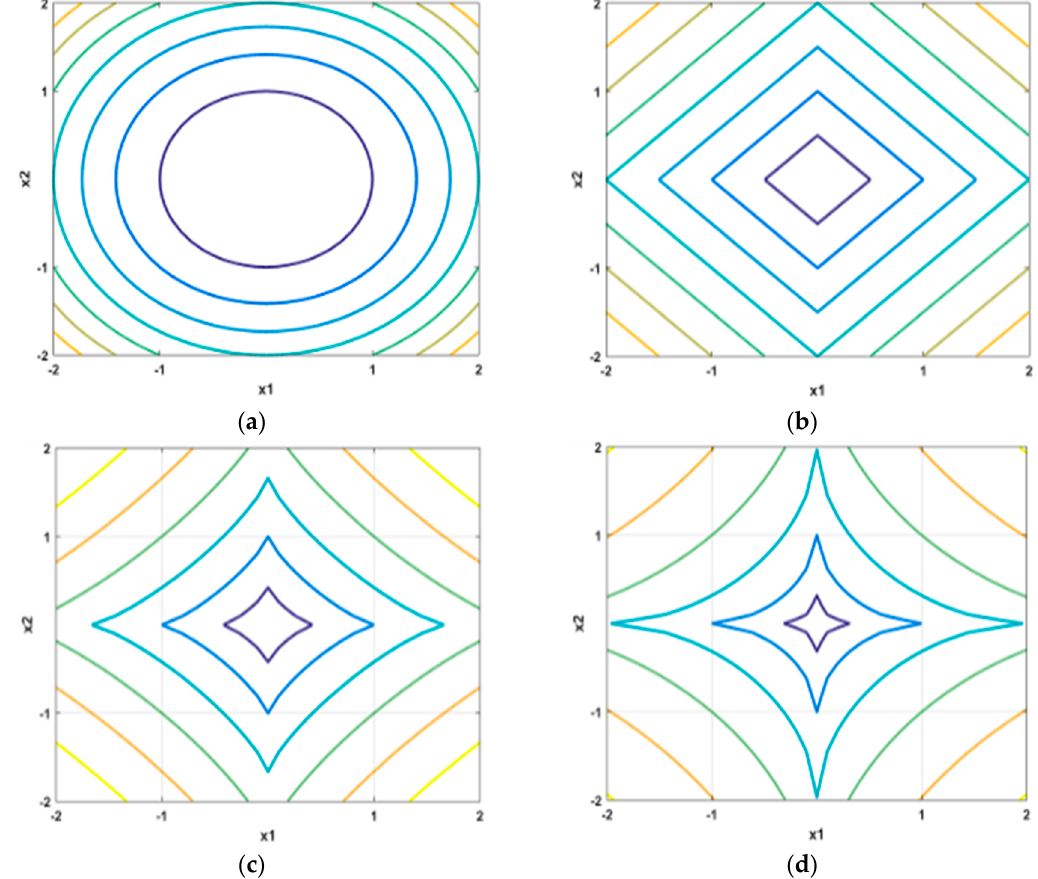
Figure 1. Contour lines of Lp-pseudo-norm: (a) p = 2; (b) p = 1; (c) p = 0.8; (d) p = 0.6.